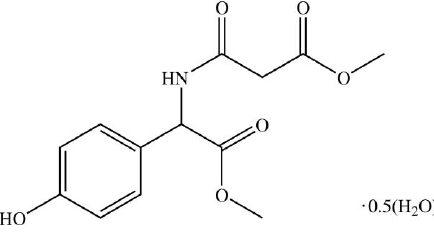
Data collection Bruker SMARTAPEX2 CCD area- detector diffractometer Absorption correction: multi-scan ( SADABS ; Bruker, 2005) T min = 0.956, T max = 0.996 Refinement